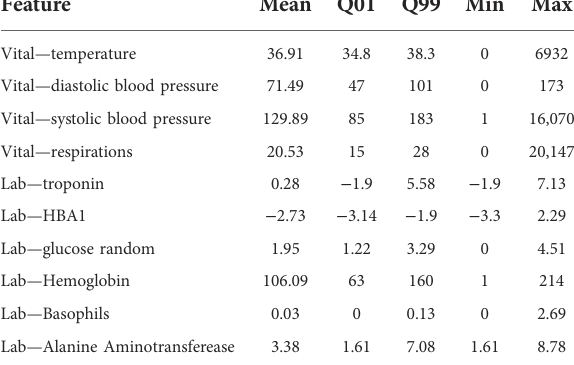
TABLE 1 Example of measured labs and vitals in the CHARTwatch training dataset. For these vitals and labs, we report their mean values, the 1st quantile (Q01), the 99th quantile (Q99), minimum value (Min) and maximum value (Max). The minimum and maximum values often fall outside of the range of biologically possible values (e.g., a maximum body temperature value of 6932